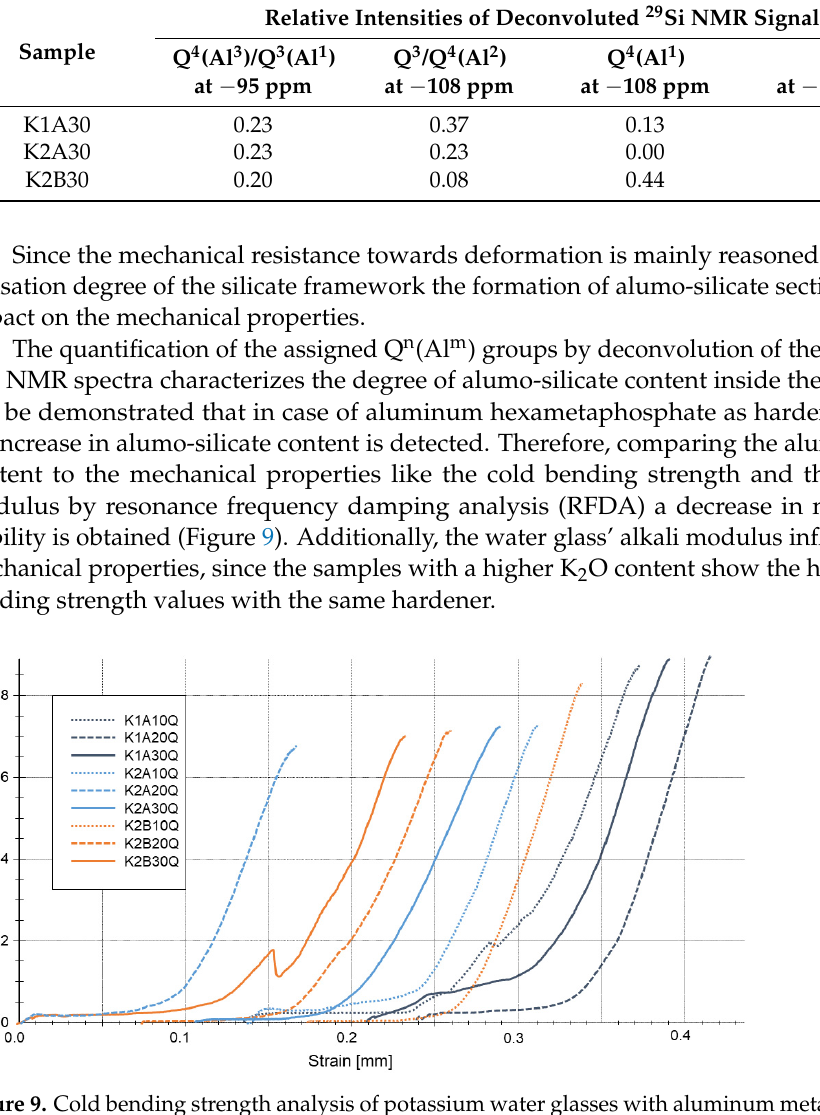
Table 2. Relative intensities of Q n and Q n (Al m ) signals in the 29 Si MAS NMR spectra of aluminum metaphosphates hardened potassium water glass binders after deconvolution, where Q n stands for the coordination of the silicate group and the m stands for the substituted O-bridged Si-heteroatom connections. Samples with potassium water glasses K1 and K2 (alkali modulus K1 < K2), and 30 wt% of aluminum metaphosphates A = aluminum tetrametaphosphate, Al 4 (P 4 O 12 ) 3 and B = aluminum hexametaphosphate, Al 2 P 6 O 18 . [construct. [22], assignment of the Q n (Al) m signals based on studies